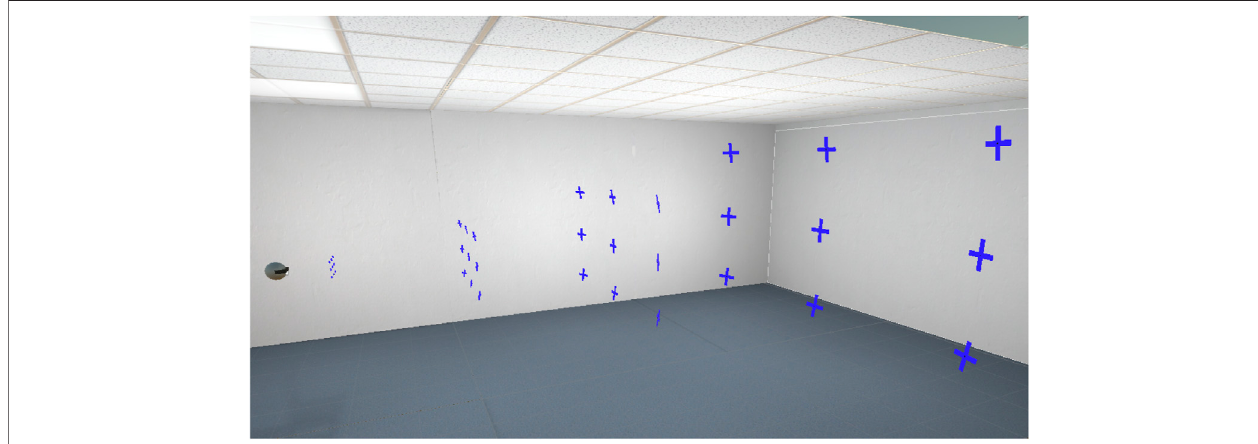
FIGURE 3 | The virtual of fi ce environment used in the study. Participant head illustrated on left. All possible stimulus targets are here presented at once. However, only a single stimulus was presented on a given trial during the study. Stimulus targets here shown 5x larger for visibility in fi gure.